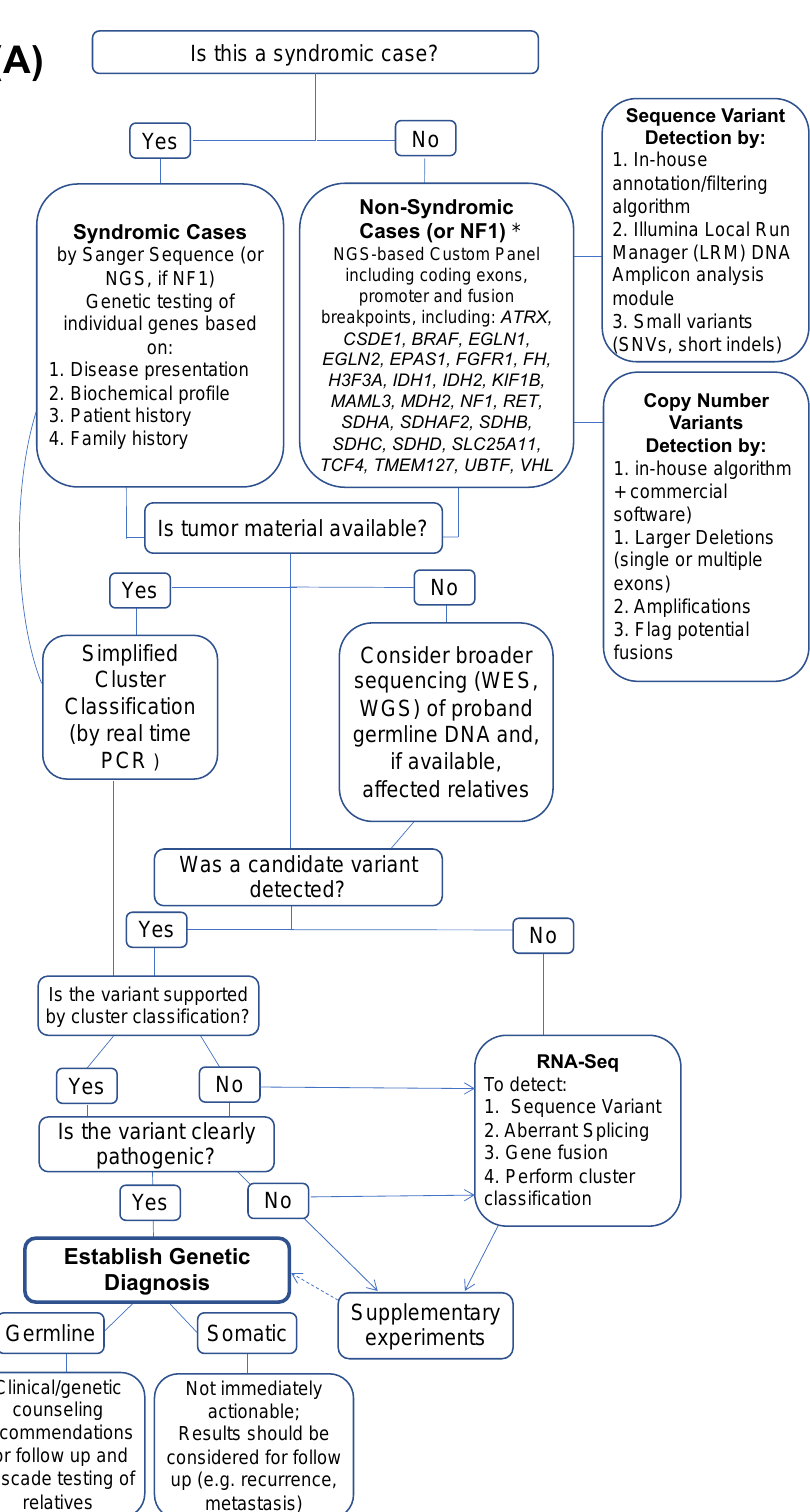
algorithm 2. Illumina Local Run